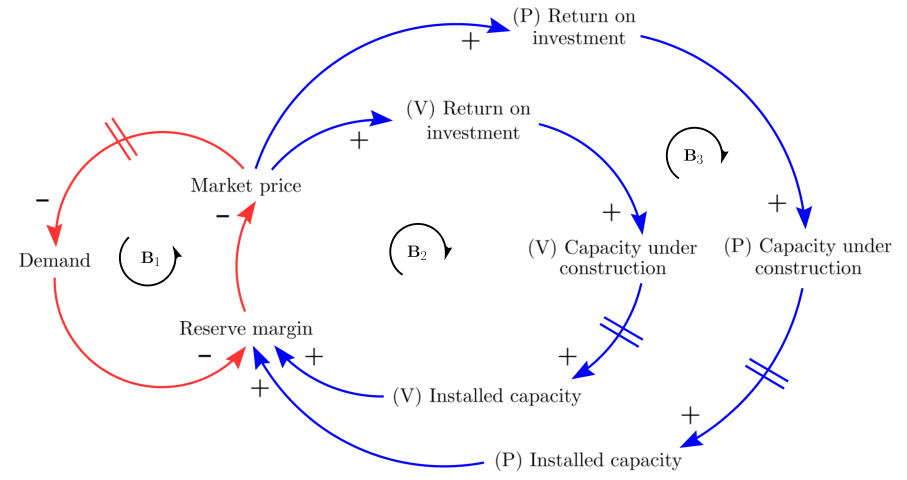
Figure 1. Dynamic hypothesis derived from